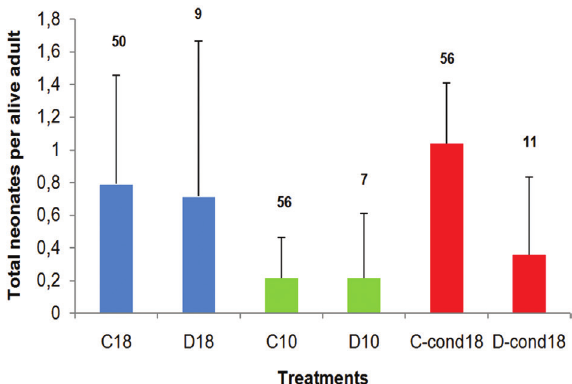
Figure 4. Mean (+ SD) of the total number of produced neonates per live adult in each treatment at 7 days after rehydration ( n = 1 observation). Numbers indicate live adults of each treatment. No significant differences were found between desiccation treatments nor between controls and desiccation treatments ( p > 0.01; Kruskal-Wallis and Mann-Whitney U